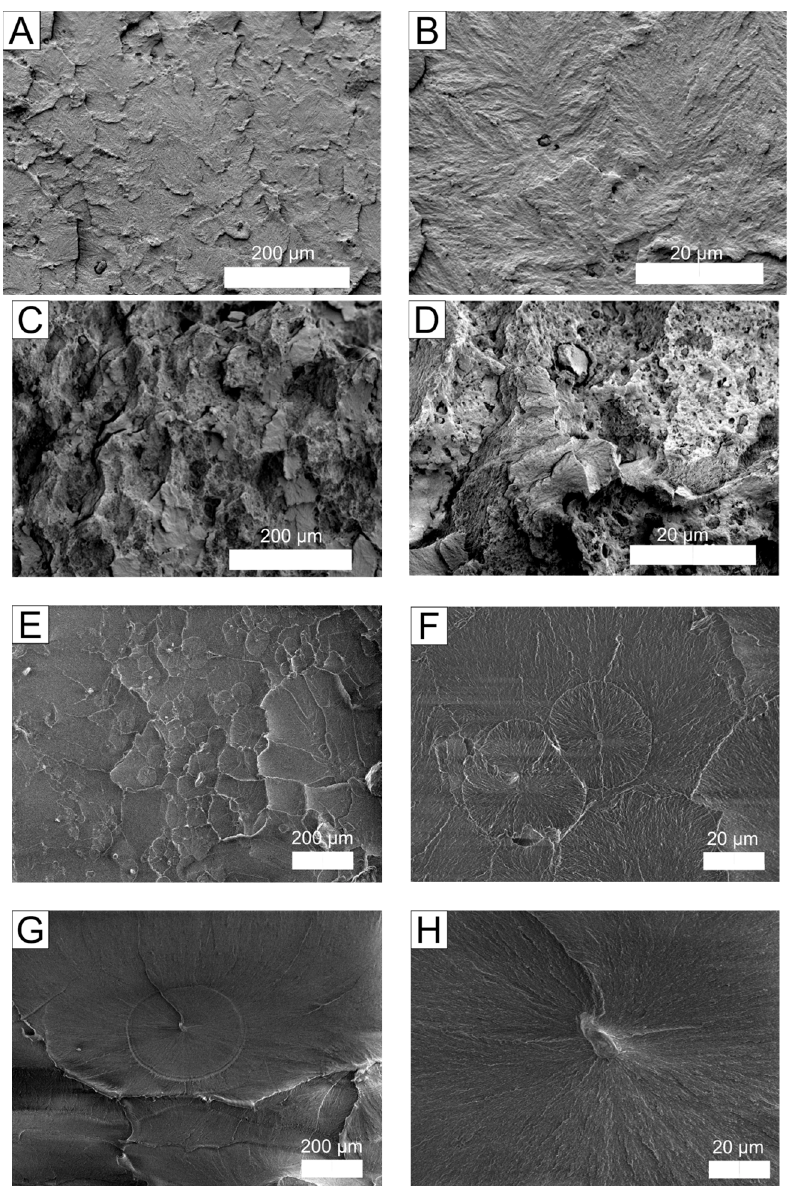
Figure 3. SEM micrographs of composites: ( A , B ) UHMWPE + 1 wt % biotite; ( C , D ) UHMWPE + 1 wt % biotite + CTAB; ( E , F ) UHMWPE + 1 wt % biotite + ADBAC; ( G , H ) unmodified UHMWPE. UHMWPE: ultra-high molecular weight polyethylene; CTAB: cetyltrimethylammonium bromide;